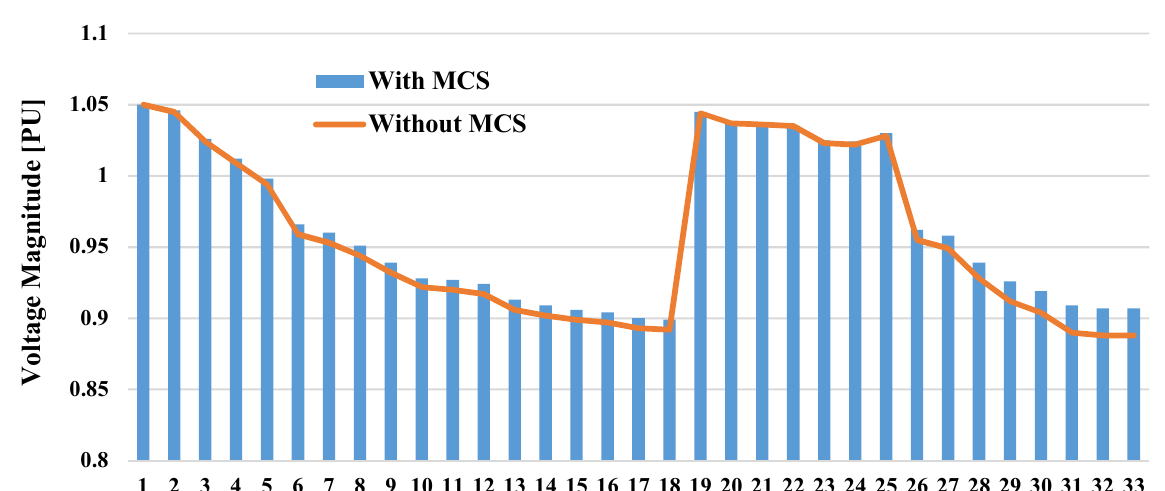
Figure 14. Voltage magnitude of the network buses at peak hour.